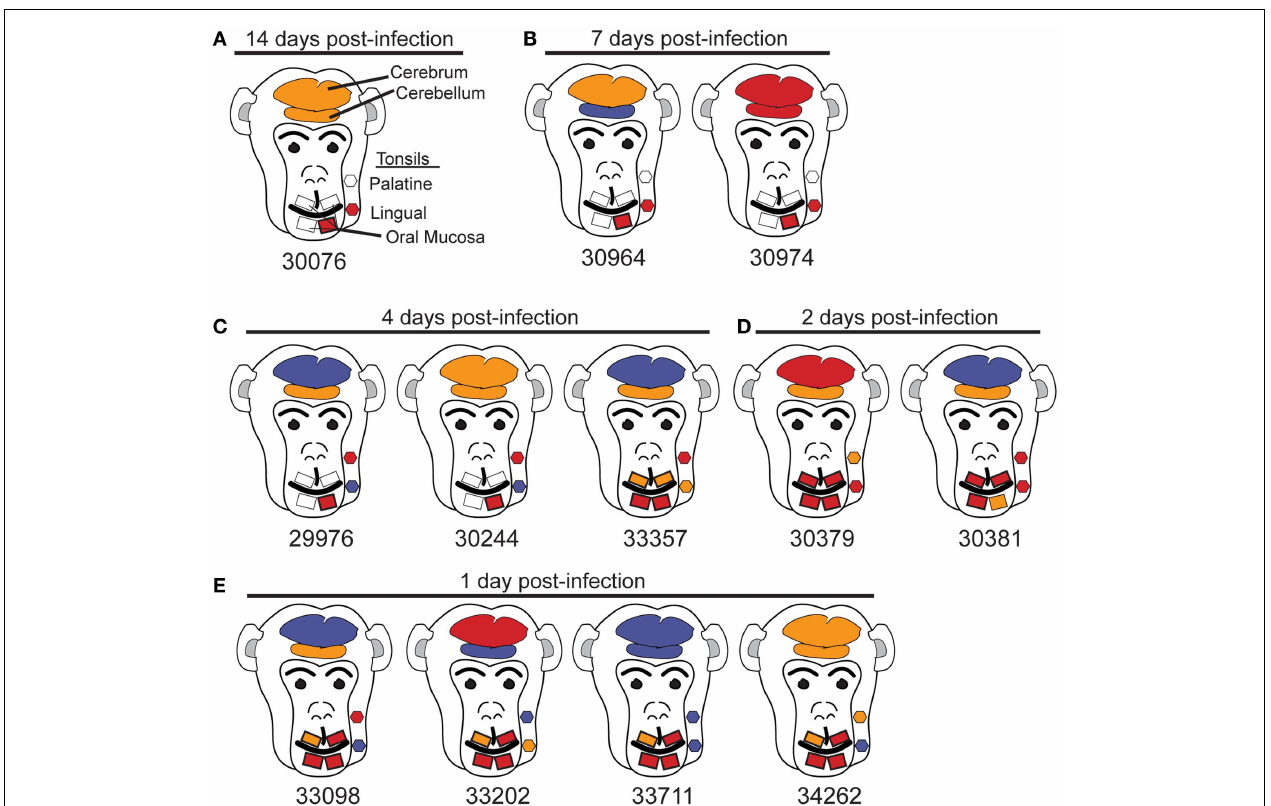
tissues. Despite perfusing these animals, SIV gag DNA was detected in the brain. Results are based on the number of SIV gag DNA-positive reactions with a minimum of three reactions for non-brain tissues and seven reactions for cerebrum and cerebellum.Tissues are depicted as follows: red, 50% or more of the PCR reactions were positive; orange, less than 50% of PCR reactions positive; blue, no PCR reactions positive; gray, tissues not